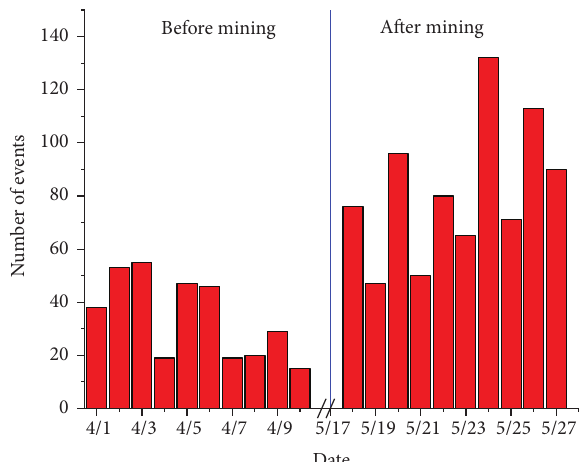
Figure 5: Comparison chart of the number of microseismic events before and after